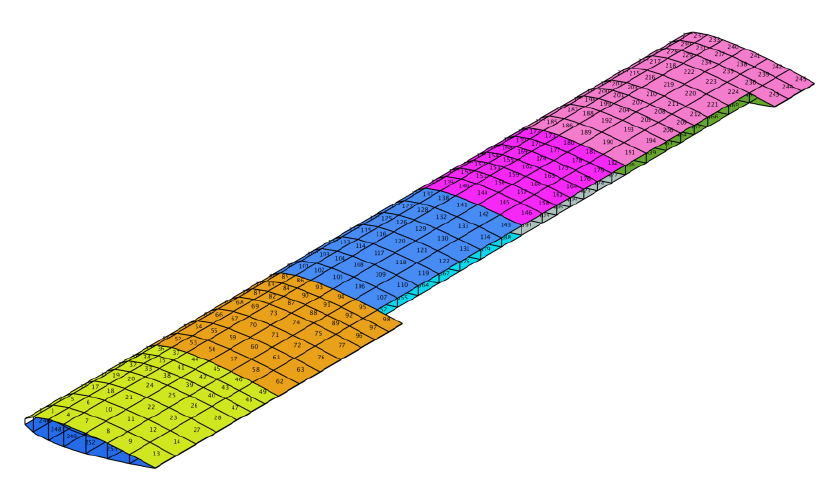
Figure 8. Design fields.